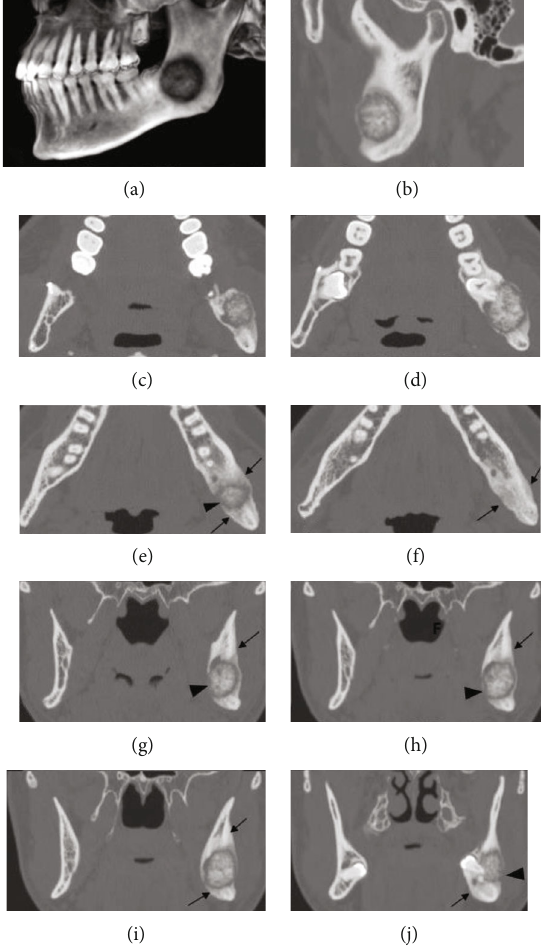
Figure 1: Case #1 3D CT reconstruction (a) and bone window CT sagittal view (b) showing the mixed density lesion associated with impacted #17 measuring 1 : 6 × 2 : 1 × 2 cm. The border of the lesion is well circumscribed with a broad sclerotic rim surrounding a lucent halo. Axial views ((c-f) from superior to inferior) and coronal views ((g-j) from posterior to anterior) showing buccal and lingual expansion, thinning, and areas of perforation at buccal and lingual cortices (arrowheads). Extensive sclerotic reactive bone is seen surrounding the lesion. New bone formation can be seen at buccal, lingual cortical, and inferior to the lesion (arrows). The lucent rim of the lesion extends into the left mandibular canal, with potential involvement of the inferior alveolar nerve (g –